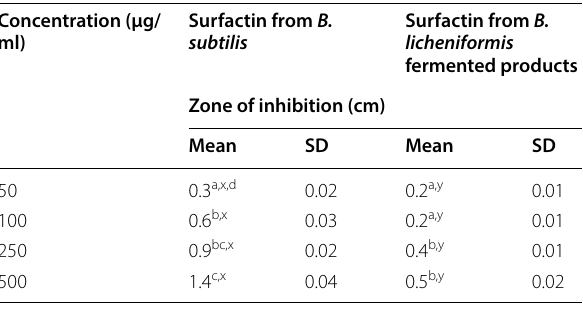
Table 2 Measurement of zone of inhibition of surfactin on B. hyodysenteriae growth at different